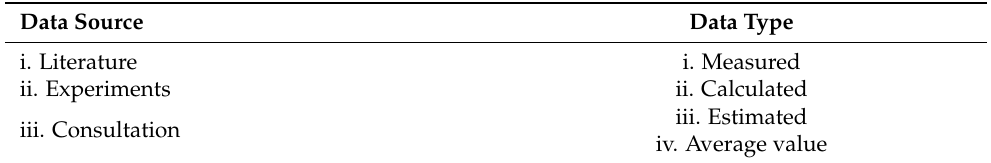
Table 3. Sources and types of data used in the study.